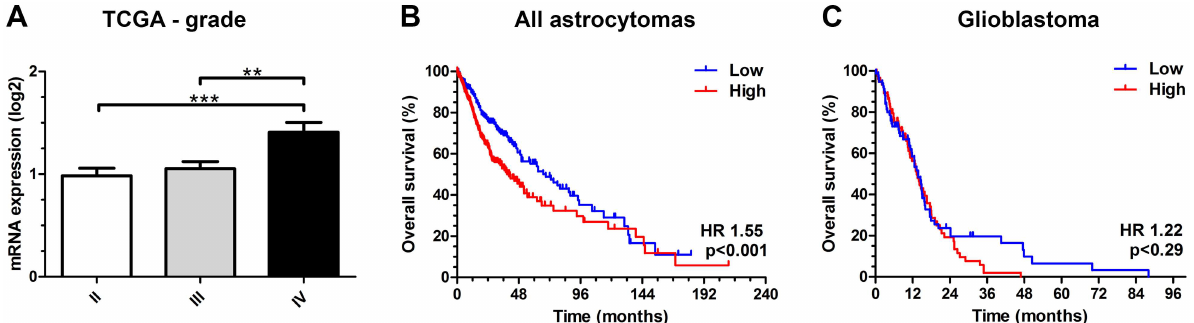
Fig 1. Oct-4 (POU5F1) mRNA expressionin the TCGA dataset. (A) The mRNA levels were significantly higherin grade IV tumors compared to grade II (p < 0.001)and grade III (p < 0.01)tumors. (B) High expression was associated with shorter overall survival when all grades were combined(p < 0.001), (C) but did not show any prognostic impact in patients with glioblastoma (p = 0.29).